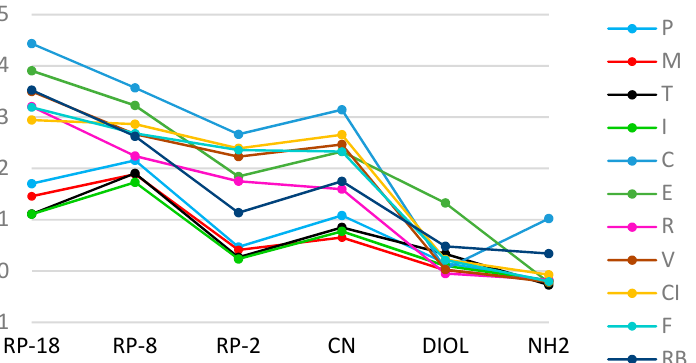
Figure 1. A plot of the relationship of R M0 values on the type of stationary phase for the tested substances in the methanol/water mobile phase.